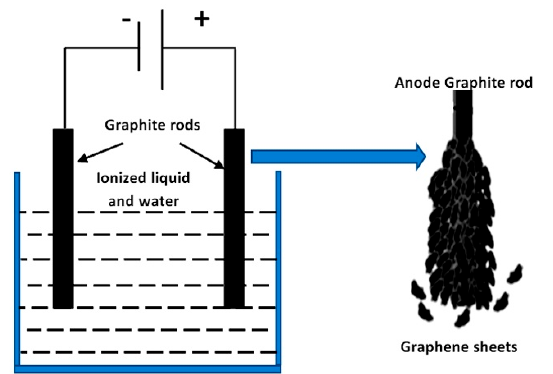
Figure 1. Schematic presentation of experimental setup and graphite anode exfoliation.